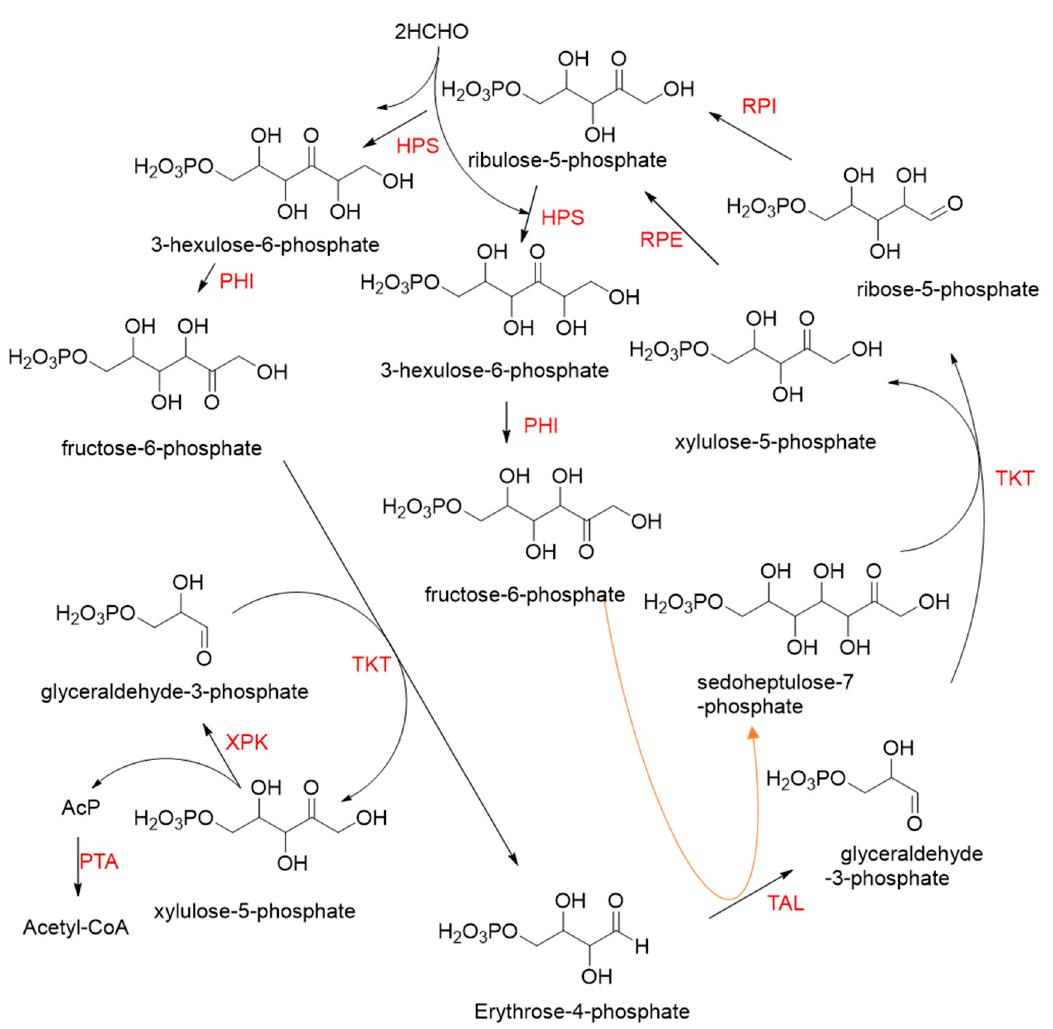
Figure 10. The methanol condensation cycle (MCC) [70]. HPS, hexulose phosphate synthase; PHI, phosphohexulose isomerase; TAL, transaldolase; TKT, transketolase; RPE, D-ribulose 5-phosphate epimerase; RPI, Ribose-5-phosphate isomerase; XPK, phosphoketolase; PTA, phosphate acetyltransferase.